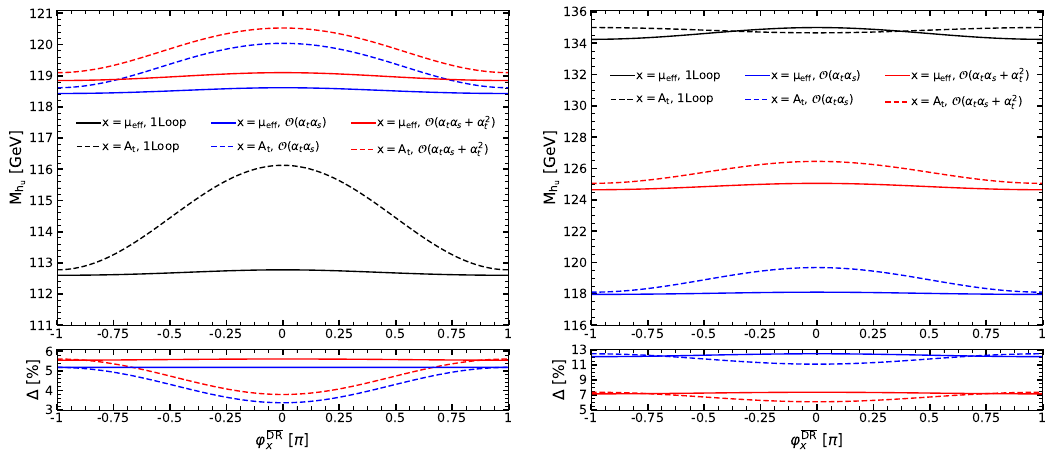
Figure 10 . Upper Panels: one-loop (black lines), two-loop O ( (cid:11) t (cid:11) s ) (blue lines) and two-loop O ( (cid:11) t (cid:11) s + (cid:11) 2 ) (red lines) mass values m h of the SM-like Higgs boson as a function of the phases t u ’ (cid:22) (full lines) and ’ A (dashed lines). Lower Panels: absolute value of the relative two-loop t corrections to the mass of the SM-like Higgs boson with respect to the one-loop order | i.e. (cid:1) = j M (2 ;x ) (cid:0) M (1) j =M (1) | in percent as a function of the phases ’ (cid:22) (full), and ’ A h u h u h u x = O ( (cid:11) t (cid:11) s ) (blue lines) and x = O ( (cid:11) t (cid:11) s + (cid:11) 2 ) (red lines). Left: DR, right: OS scheme in the t top/stop